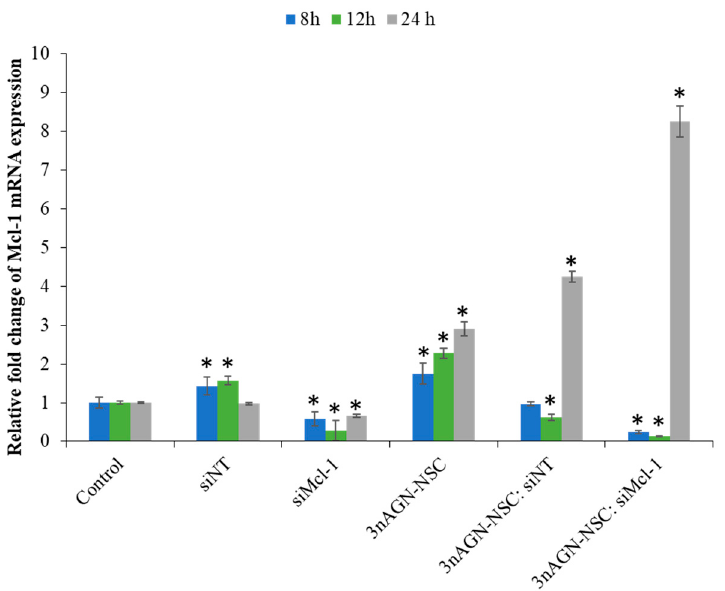
Figure 5. The mRNA expression study was examined using the △△ CT method, which is presented as a percentage of the relative fold change of Mcl-1 mRNA expression in the MCF-7 cells. * The data are significantly different from control in each time point ( p < 0.05).